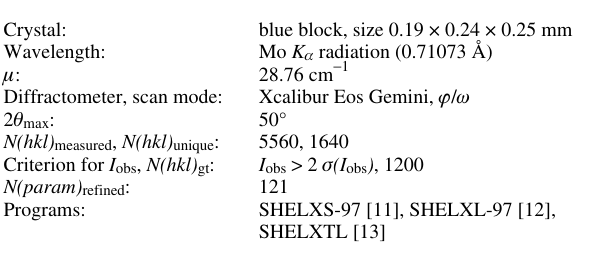
Table 1. Data collection and handling.